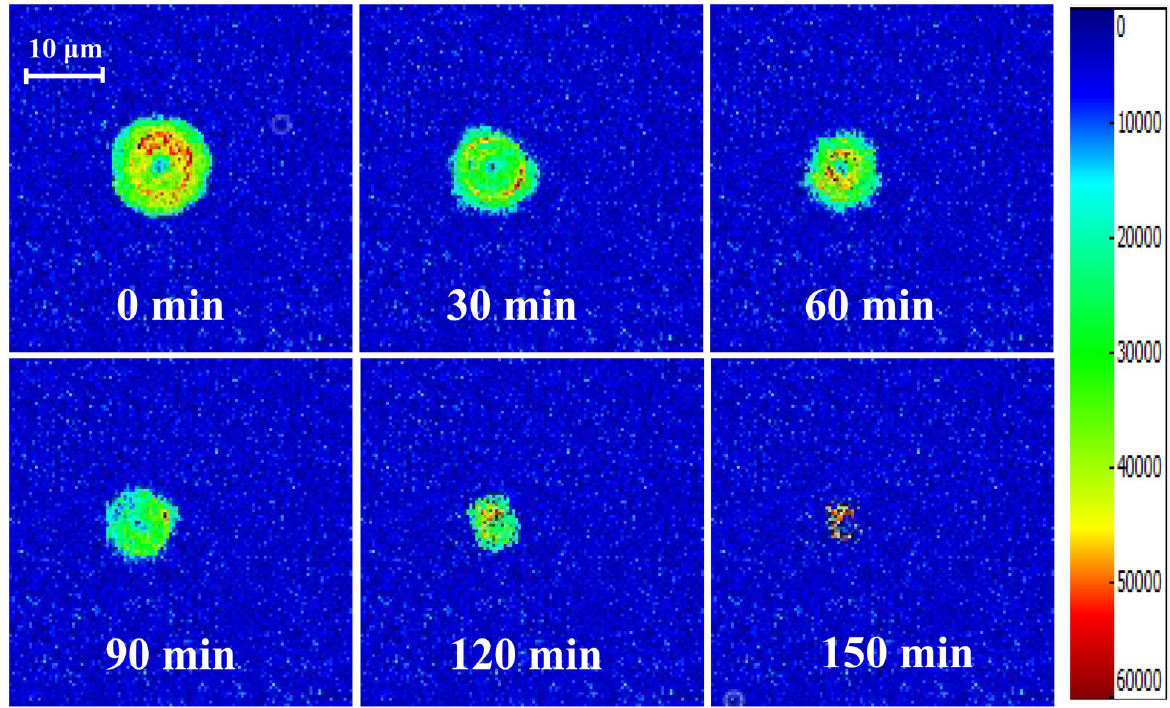
Fig 4. T 2 -weighted MRI images of AR pieces drying at